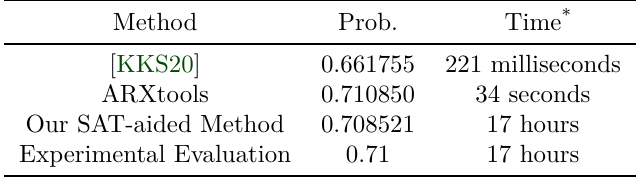
Table 5: The Estimated Probabilities of the Switch in LEA Method Prob.